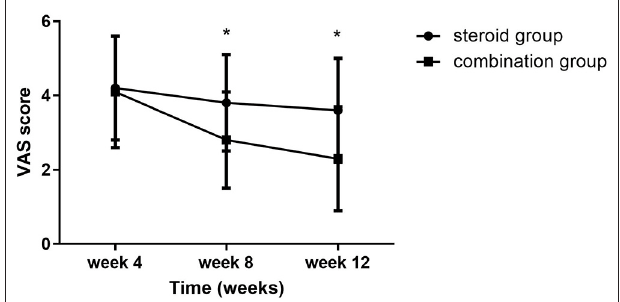
and BCTQf ( F = 3.543, P = 0.035). When compared with steroid group, VAS, BCTQs, and BCTQf scores of combination groups declined significantly at weeks 8 and 12 ( P < 0.01) ( Figures 2 – 4